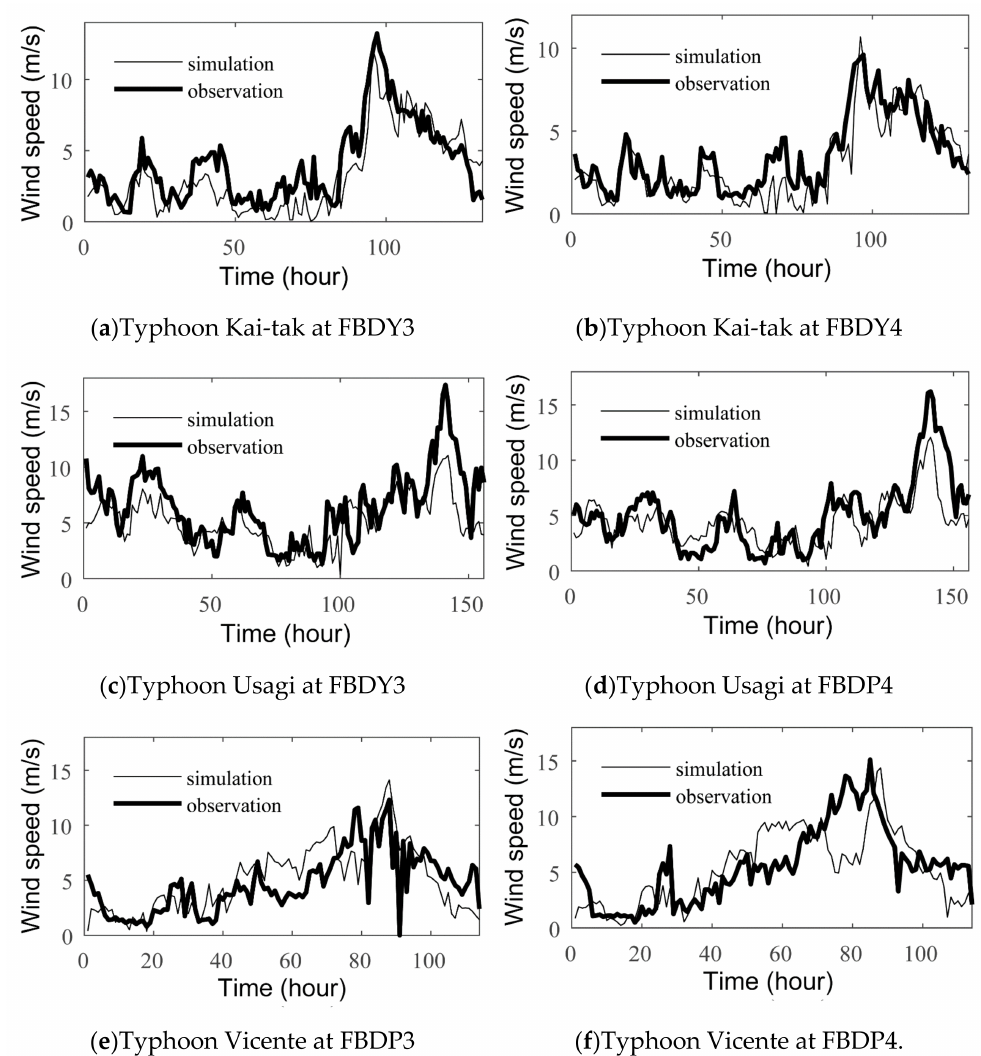
Figure 5. The magnitude of the wind velocities simulated/measured at offshore buoys, ( a , b ) Typhoon Kai-tak, ( c , d ) Typhoon Usagi, ( e , f ) Typhoon